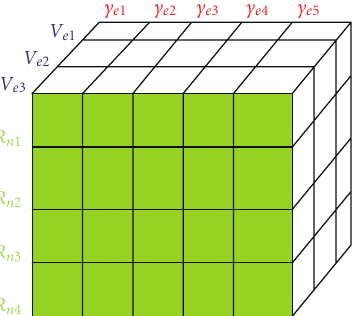
Figure 7: Sparta OLAP cube as modeled in the